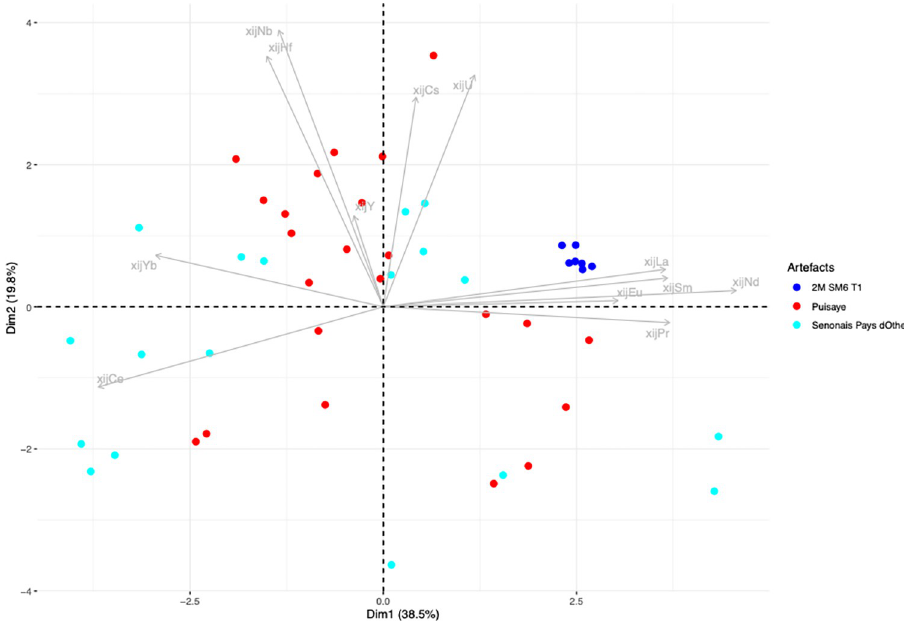
Fig 21. PCA of the artefact consistent with Se´nonais-Pays-d’Hote/Puisaye during stage 1 of statistical inference. % of total variance.